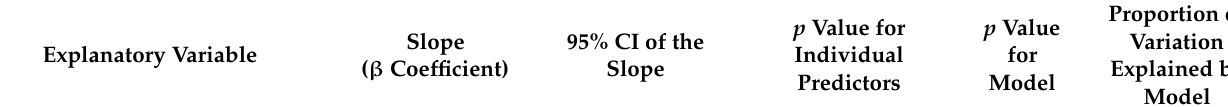
Table 3. Summary of multivariate meta-regression analysis.